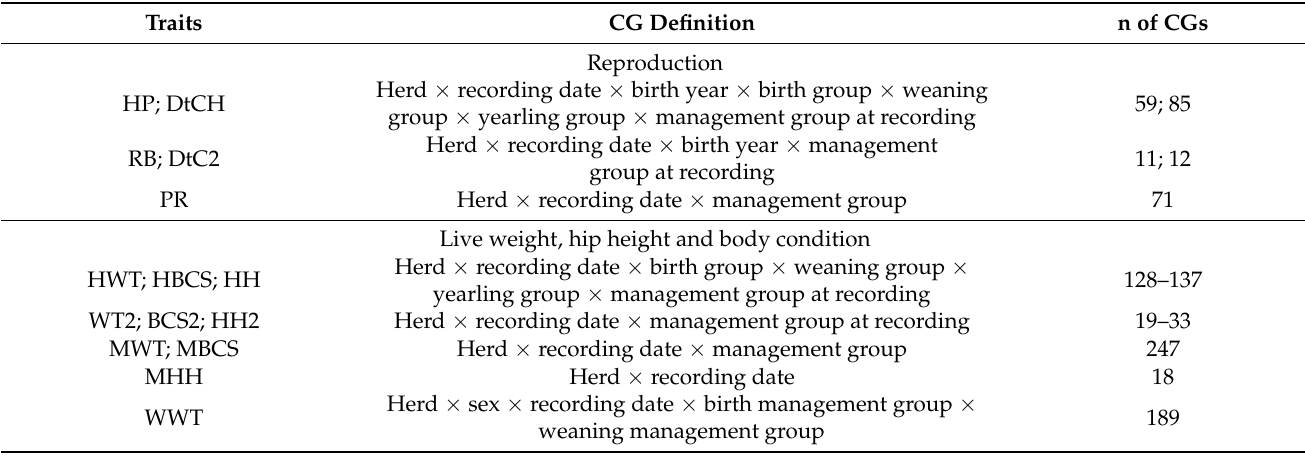
Table 2. Contemporary group (CG) definitions for each trait and number (n) of